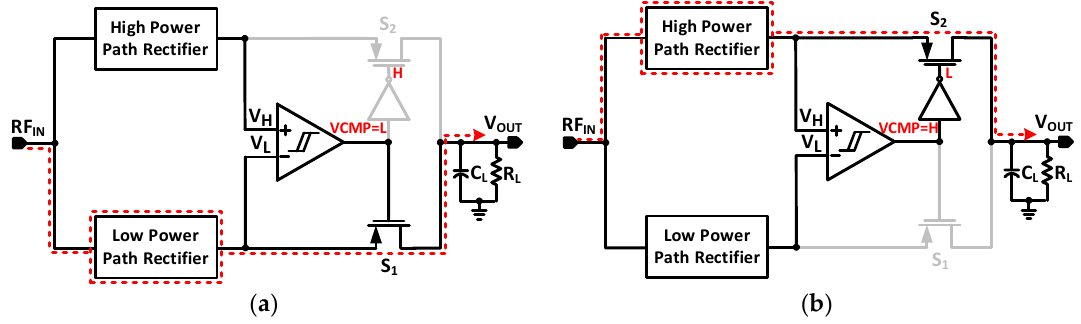
Figure 4. Proposed RF-DC converter with ( a ) operation of low-power path rectifier; and ( b ) operation of high-power path rectifier.